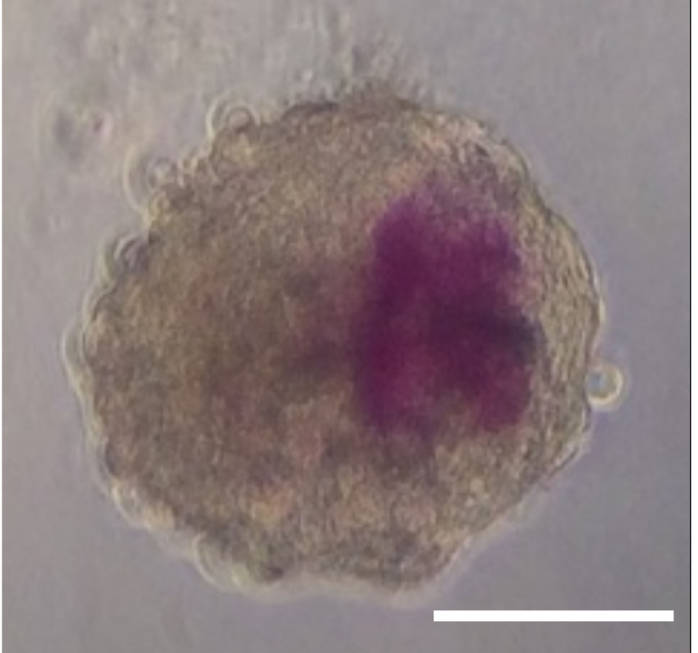
Figure 5. Brightfield image of a spheroid model of the bone marrow comprised of 1000 human bone marrow-derived MSC (grey, unstained) and 500 cord blood-derived HSC (purple), the latter stained with CytoTracker Orange. The spheroids are similar to those of De Barros et al. [104]. The formation of an HSC niche is evident by the concentrated distribution of HSC in the spheroid. Scale bar denotes 100 µ